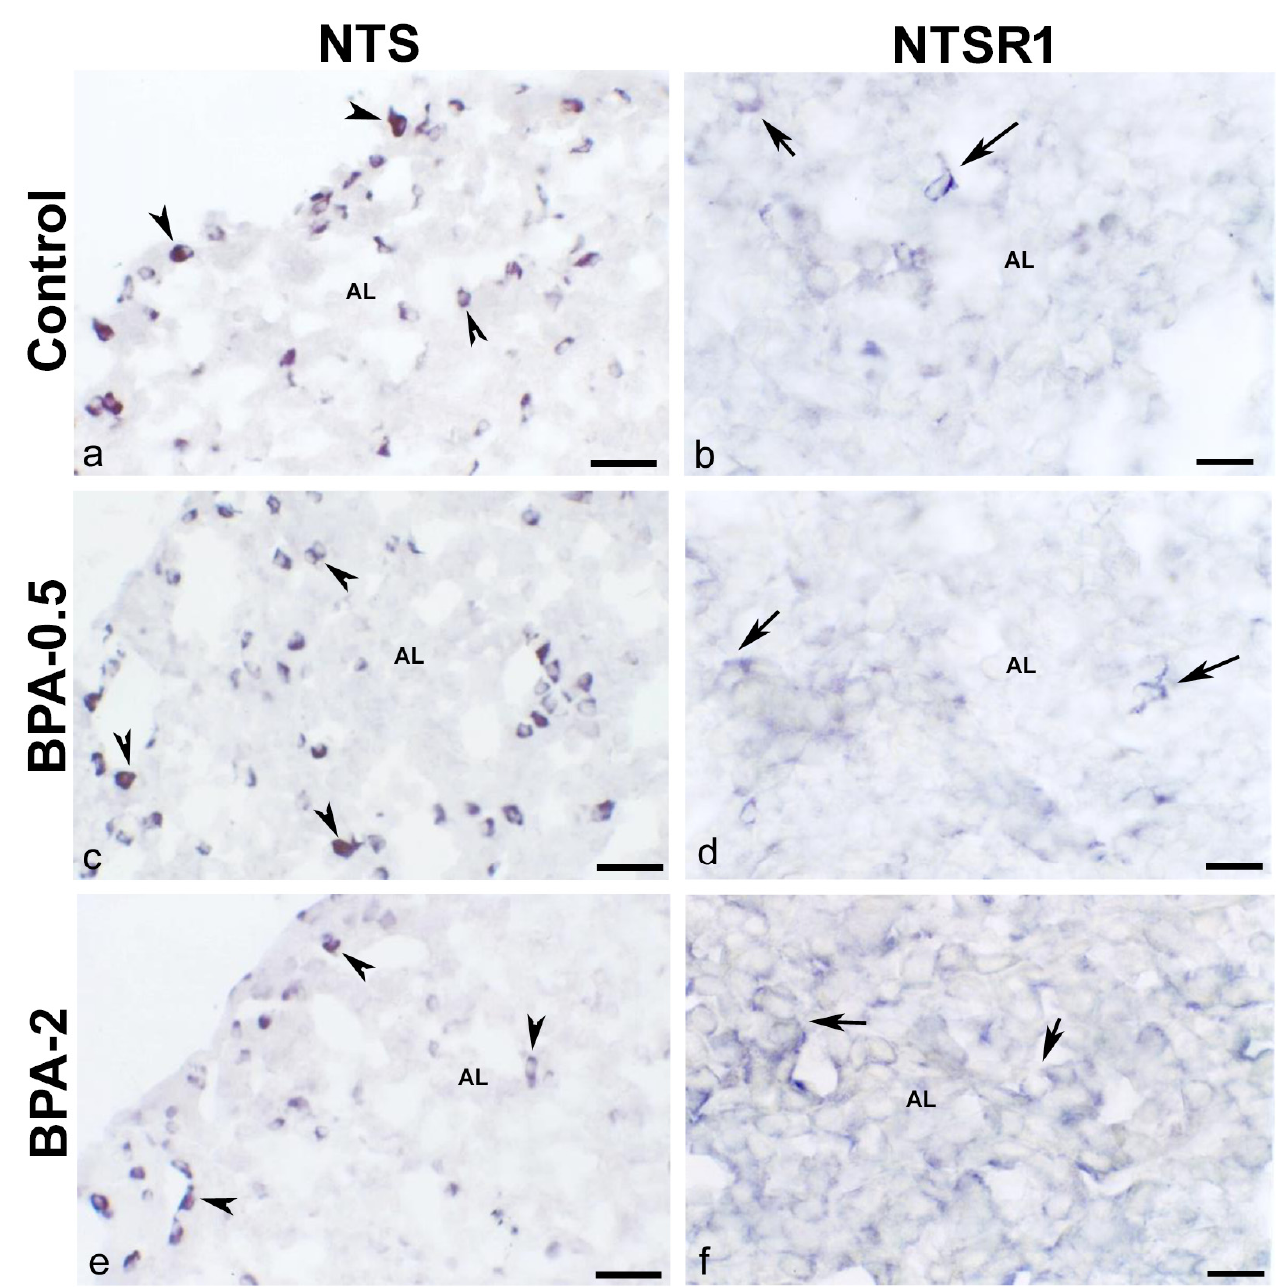
Figure 6. NTS and NTSR1 immunoreactivity in the mother’s pituitary gland. Representative images of the pituitary gland in mothers after weaning/lactation showing the presence of NTS-ir cells (arrowheads) ( a , c , e ) and NTSR1-ir cells (arrows) ( b , d , f ) in the three experimental groups. AL: anterior lobe. Scale bars: ( a , c , e ): 35 µm and ( b , d , f ): 25 µm.